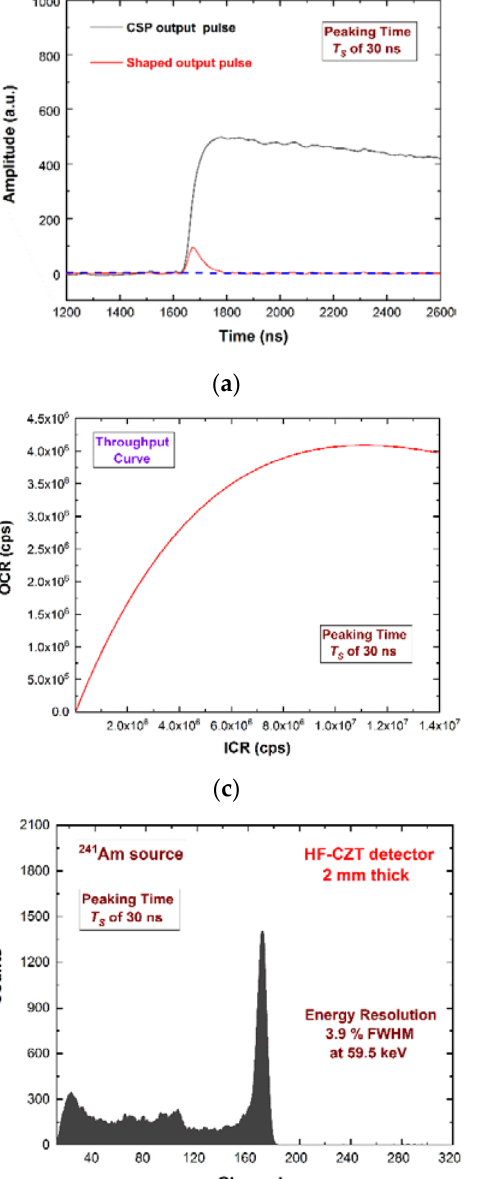
of the 2-mm HF-CZT pixel detector, in terms of throughput and energy resolution ( 241 Am (Figure 6d). Further energy spectra using the ballistic deficit pulse processing are shown source). in Figure 7.